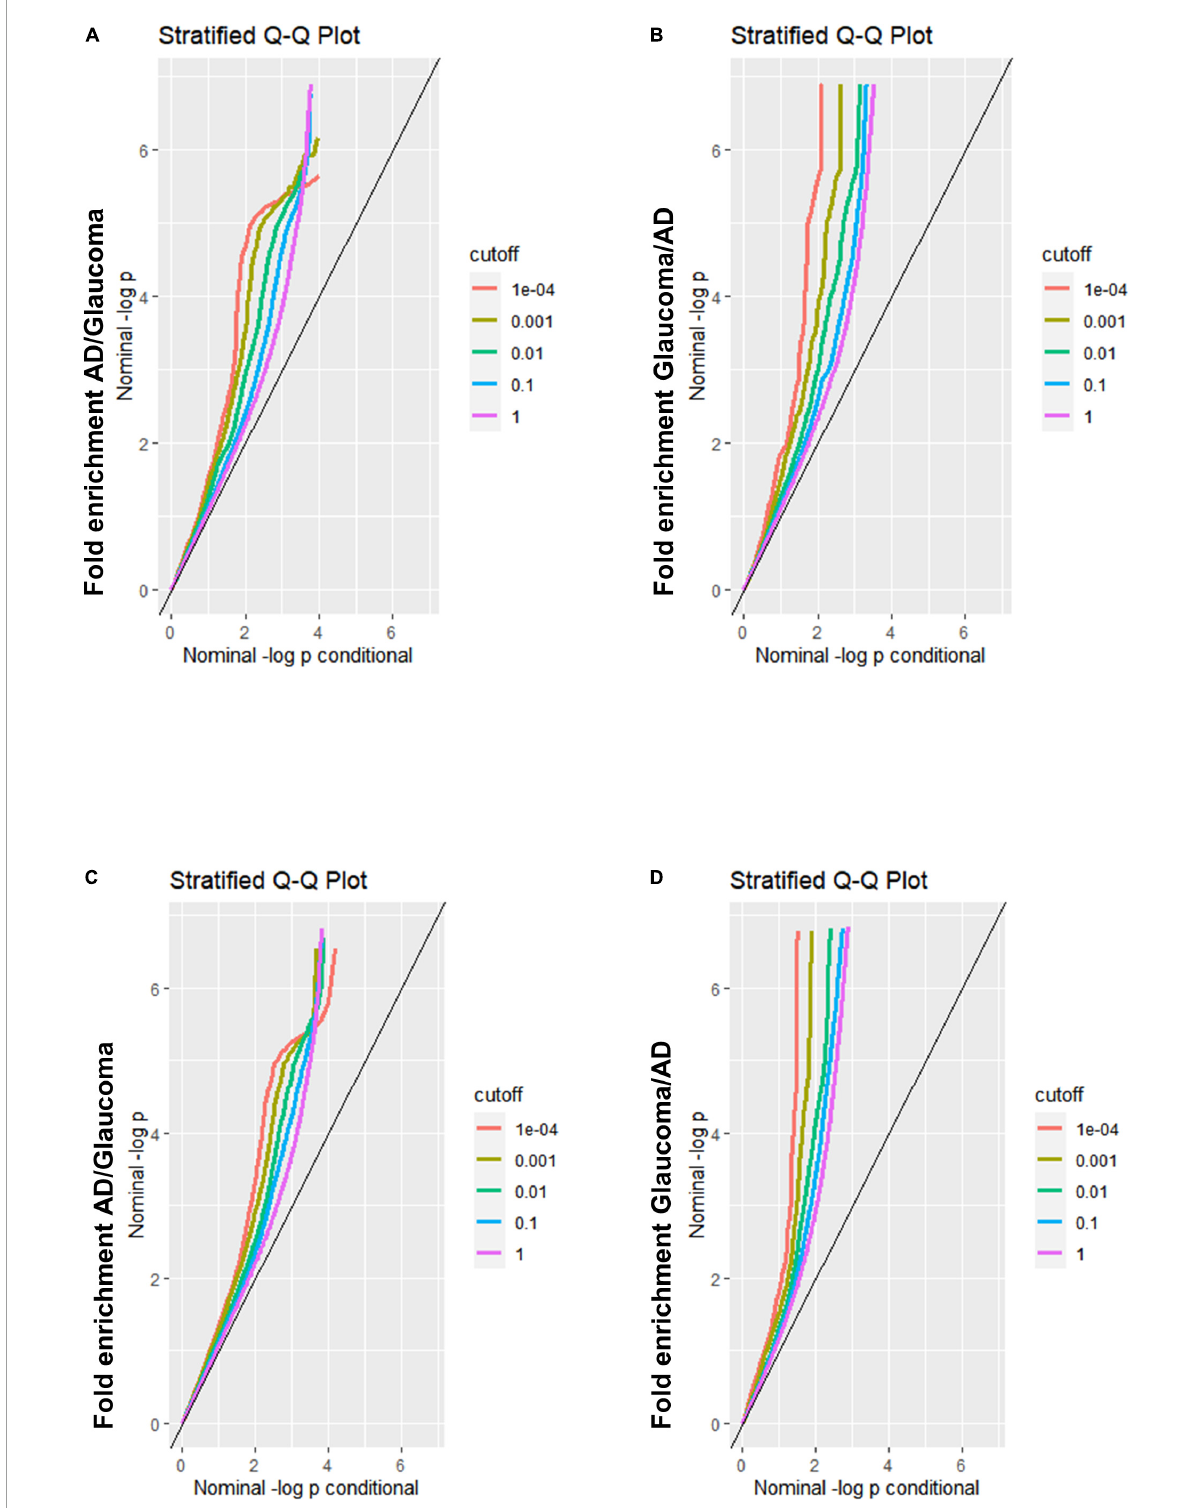
FIGURE1 Fold-enrichment plots for genetic association analysis between AD and glaucoma discovery/replication samples. (A) Fold-enrichment plot of nominal –log 10 (p) for SNPs association with AD as a function of statistical significance for SNPs association with glaucoma discovery sample.